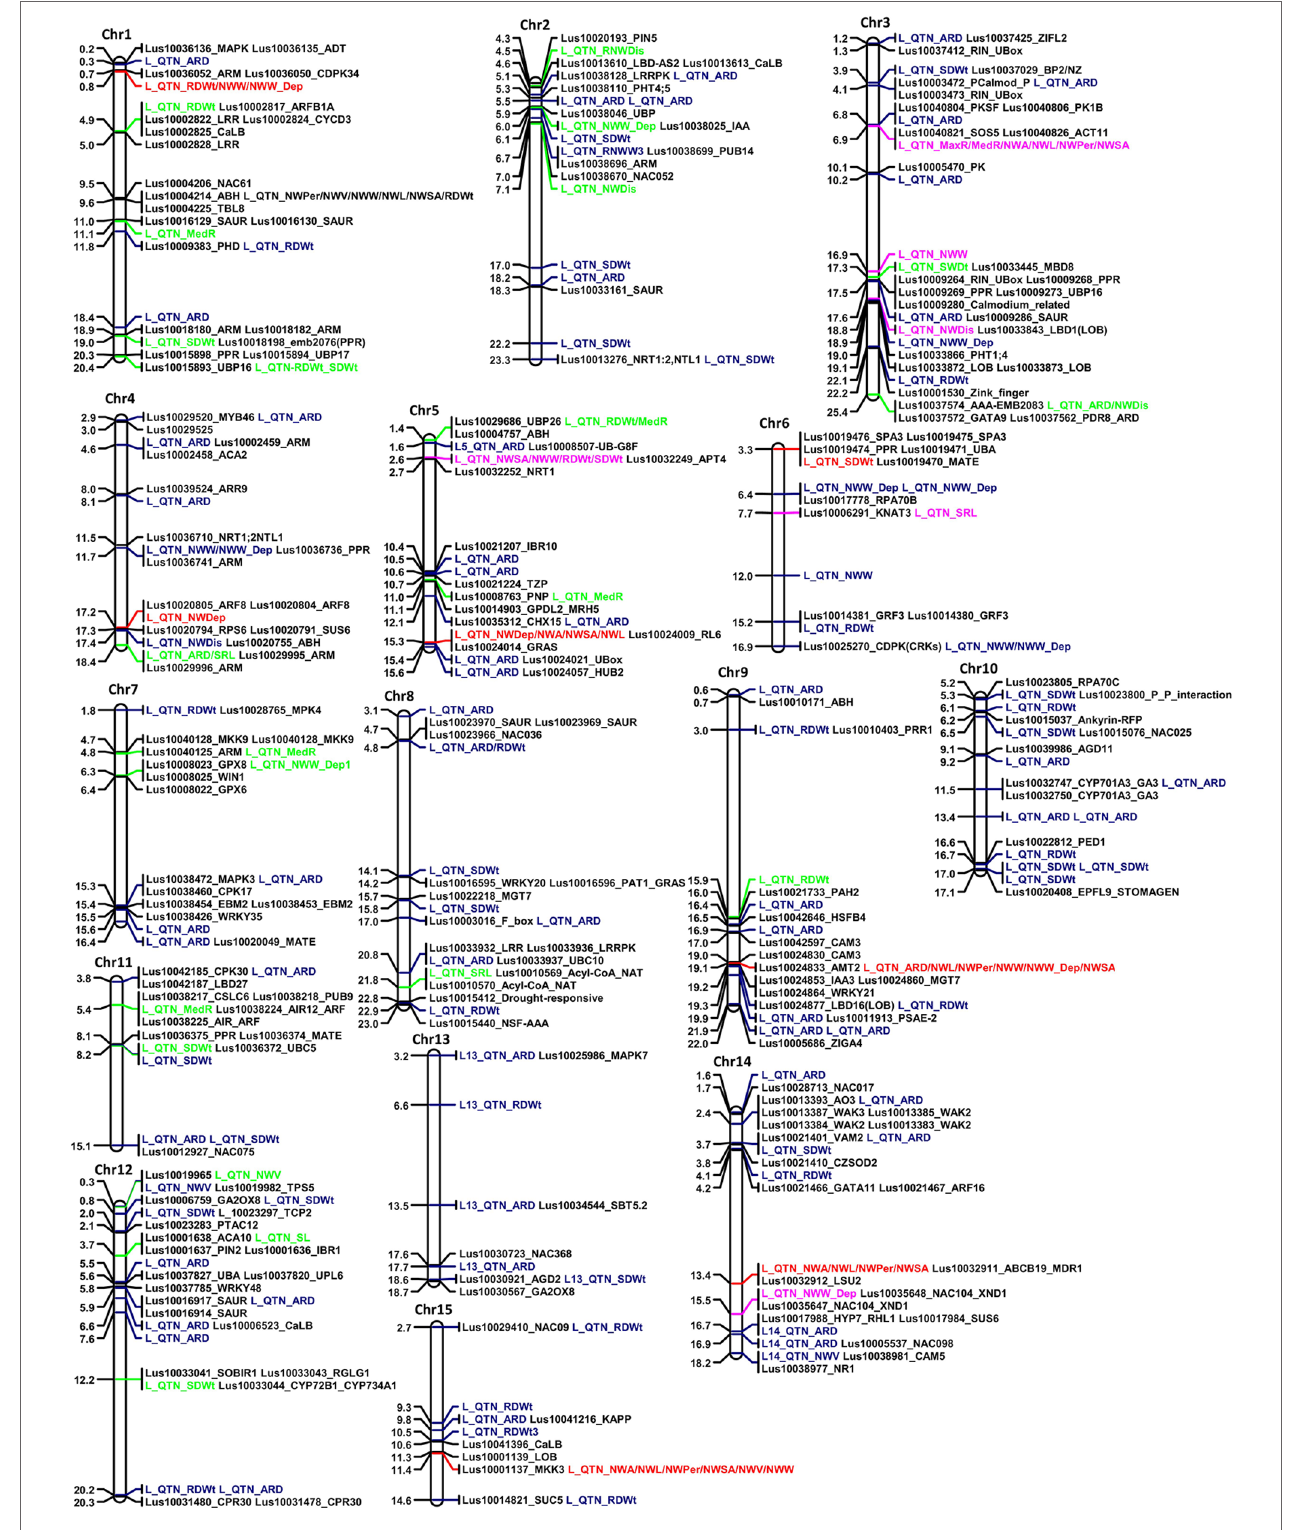
FIGURE 6 | Physical map of the 15 chromosomes of flax illustrating the position of the quantitative trait nucleotides (QTNs) and their proximal candidate genes (right of the chromosomes). QTNs with R 2 > 5% in the 3K, 7K or in both datasets are in green, purple, and red, respectively. QTNs indicated in blue have R 2 < 5% and were detected in the 3K dataset. Numbers on the left of the chromosomes represent physical distances in megabases.